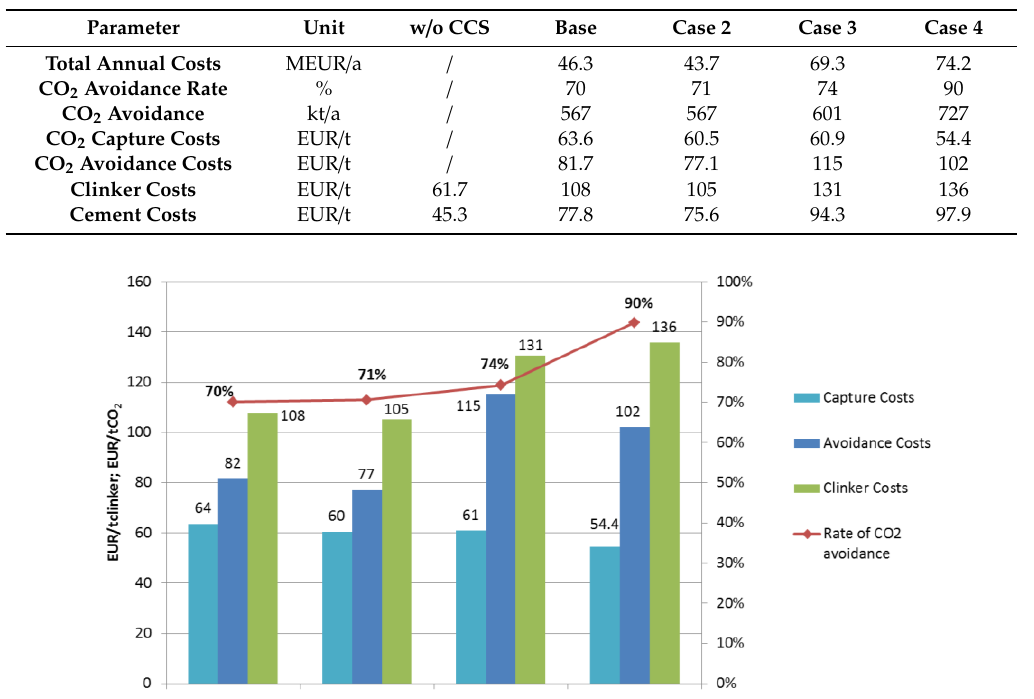
Figure 3. Capture, avoidance, and clinker costs and CO 2 avoidance [%] for carbon capture in cement plants; investigated cases.